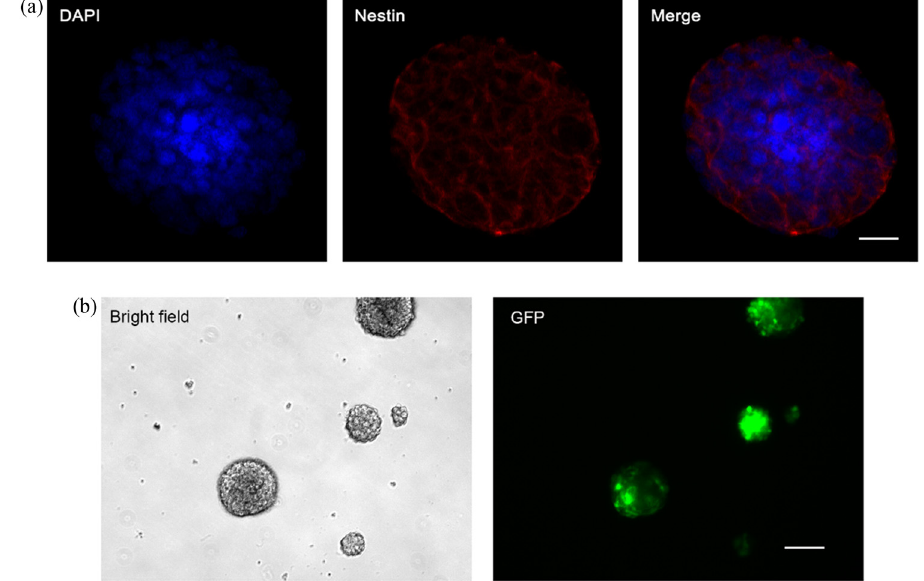
Figure 1: NSCs identi fi cation and infection. ( a ) Cell spheres were immunostained with nestin antibody and nuclei were labeled by DAPI. The images were captured by a Zeiss LSM 710 confocal microscope with a 63 × objective ( Red, nestin; Blue, DAPI ) . Scale bar = 20 µm. ( b ) Stem cells were infected with adenovirus expressing GFP. The images were captured by fl uorescent inverted microscope with a 10 × objective. Scale bar = 200